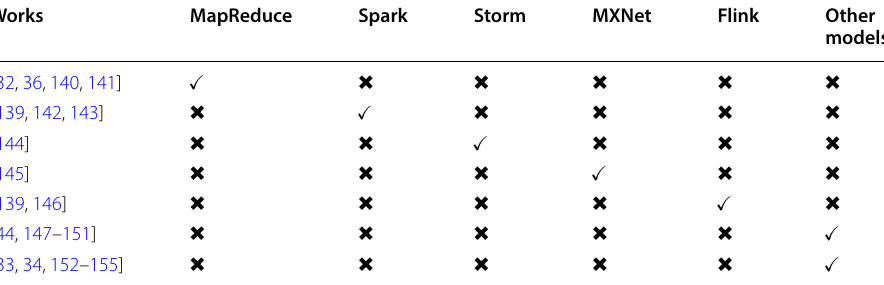
Table 6 Review of big data tools in context of anomaly detection